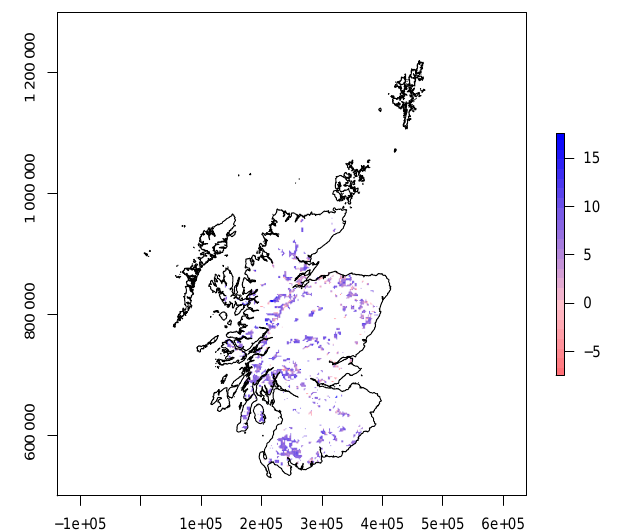
Figure 12. Net carbon flux (in kgCm − 2 ) from land-use change in Scotland over 1969–2015 from the maximum a posteriori estimate of U . Positive fluxes denote a gain to the terrestrial carbon stock; negative fluxes represent a loss to the atmosphere. Map coordinates are in British National